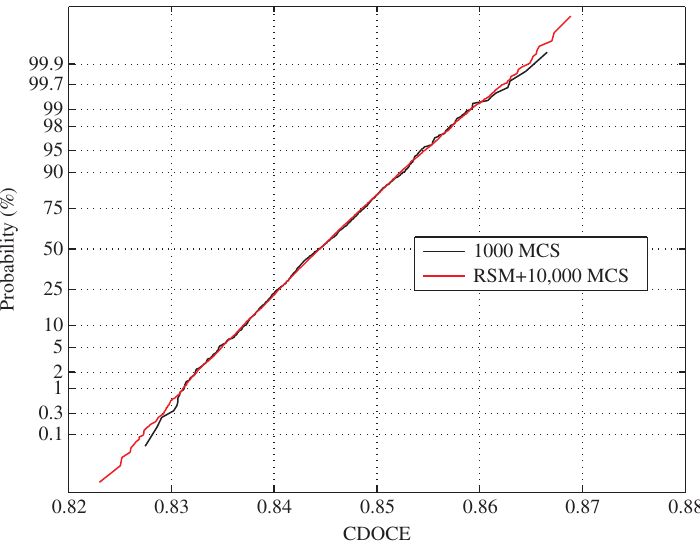
Figure 5 CDFs of case 1.1 (1,000 MCS with LHS) and case 1.2 (RSM+10,000 MCS) in the form of a Gauss plot.